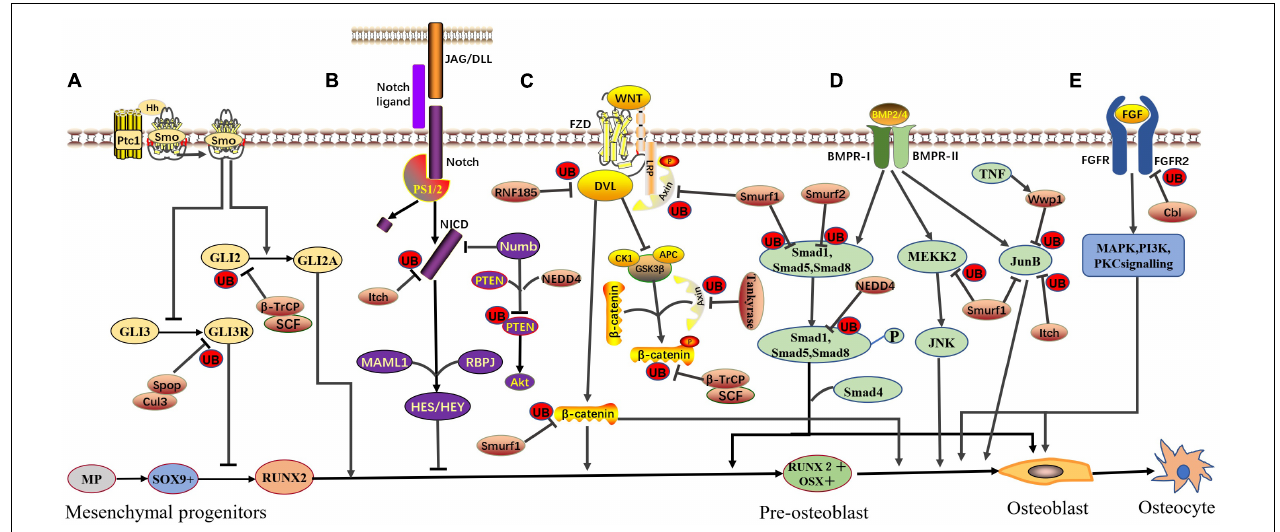
FIGURE 1 | E3 ubiquitin ligase-mediated signaling pathways in osteoblast differentiation. Various E3 ubiquitin ligases and signaling pathways function in a coordinated manner to ensure osteoblast differentiation. The involved signaling pathways are described below. (A) Hedgehog signaling: SCF β - TrCP directly interacts with phosphorylated Gli2 and promotes Gli2 ubiquitination and degradation, negatively regulating HH signaling. Spop, part of the Cul3 ubiquitin ligase complex, negatively regulates HH signaling by targeting Gli3R for ubiquitination and degradation. (B) Notch signaling: Itch binds the N-terminal portion of the NICD and promotes NICD ubiquitination and degradation, negatively regulating Notch signaling. NEDD4 forms a complex with Numb and PTEN, leading to the ubiquitin-mediated proteasomal degradation of PTEN and positively regulating Notch signaling. (C) Canonical Wnt signaling: RNF185 targets Dvl2, promotes Dvl2 ubiquitination and degradation, and negatively regulates WNT signaling. Tankyrase stimulates the ubiquitination and degradation of Axin and positively regulates WNT signaling. Smurf1 mediates Lys29-nonproteolytic polyubiquitination degradation of Axin, physically interacts with β -catenin, promotes β -catenin ubiquitination and degradation, and negatively regulates WNT signaling. SCF β - TrCP specifically recognizes GSK3 β -phosphorylated β -catenin, promotes β -catenin ubiquitination and degradation, and negatively regulates WNT signaling. (D) BMP signaling: Smurf1 targets Smad1, MEKK2, and JunB, leading to their ubiquitination and degradation and negatively regulating BMP signaling. Smurf2 can also target Smad1 for ubiquitination similar to, but independent of, Smurf1. WWP1 (under TNF-induced conditions) and Itch can also target JunB and promote JunB ubiquitination and degradation, negatively regulating BMP signaling. (E) FGF signaling: Cbl can mediate the ubiquitination and degradation of FGFR2, subsequently inhibiting ERK1/2 and PI3K and negatively regulating FGF signaling. This figure is based on and modeled after Figure 4 in the review by Salhotra et al.